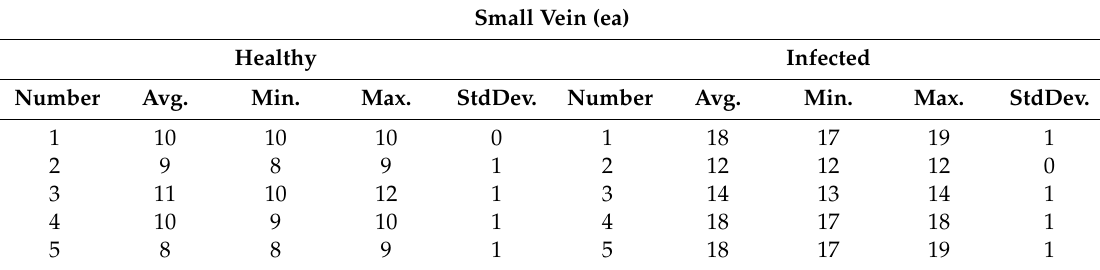
Table 2. Numerically evaluated average, minimum, and maximum leaf layer thickness compared between healthy and infected specimens with standard deviations.